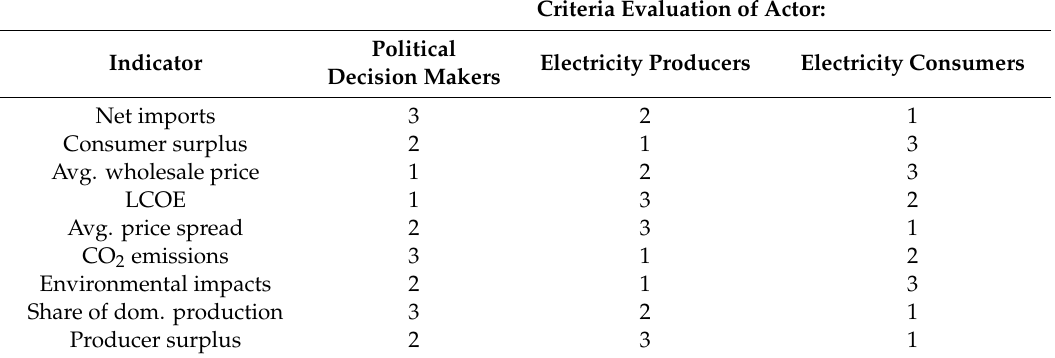
Table 3. Relevance of parameters for each actor. Source: Own compilation. LCOE: levelized costs of electricity. Criteria Evaluation of Actor: Political Indicator Decision